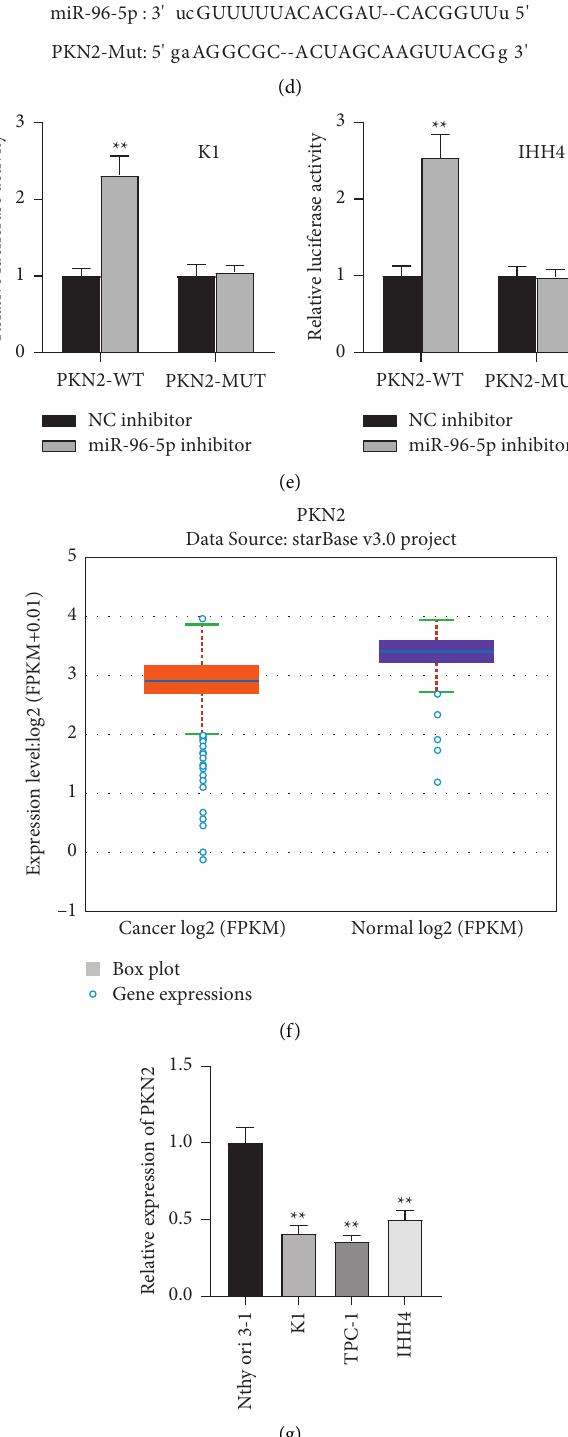
Figure 5: miR-96-5p targets PKN2. Note. (a) ENCORI website showing six candidate target mRNAs of miR-96-5p; (b) the expression of six candidate mRNAs in PTC cells after downregulating miR-96-5p; (c) the protein level of PKN2 in PTC cells after miR-96-5p downregulation was detected by western blot; (d) TargetScan showed the binding region of miR-96-5p on PKN2; (e) the binding relationship between PKN2 and miR-96-5p was validated by luciferase reporter assay; (f) ENCORI website showed the expression of PKN2 in THCA tissues compared to normal tissues; (g) the expression of PKN2 in PTC cell lines compared to normal cells was assessed by qRT-PCR. ∗ P < 0 . 05 , ∗∗ P < 0 . 01 , and ∗∗∗ P < 0 .